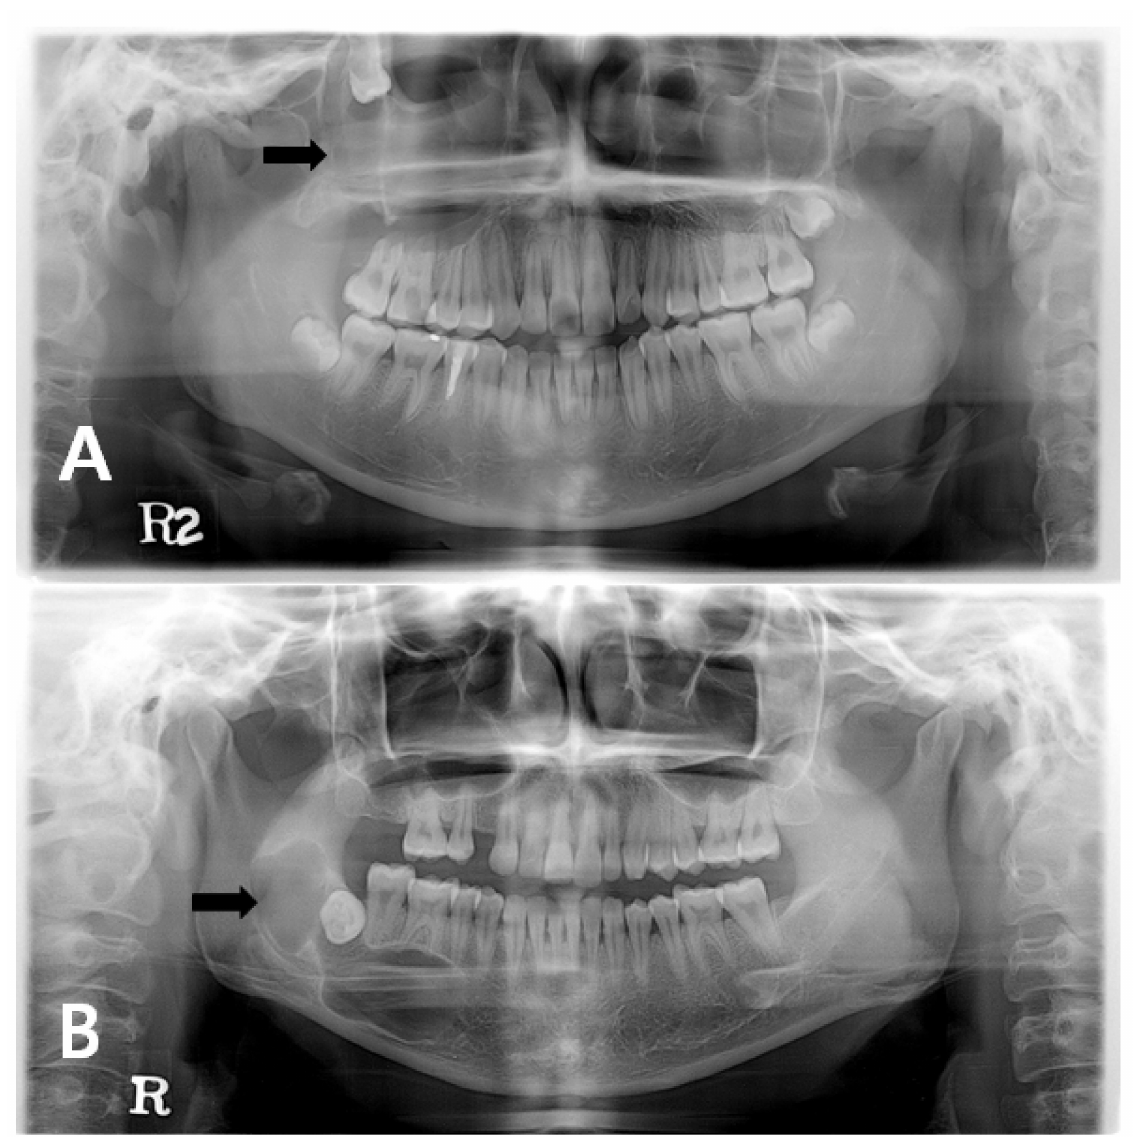
Figure 1. Radiographic image of odontogenic keratocyst (OKC): ( A ) patient with an OKC on maxilla, right. Third molar is floating inside sinus due to OKC; ( B ) patient with an OKC on mandible, right. It is showing scalloped margin with sclerotic